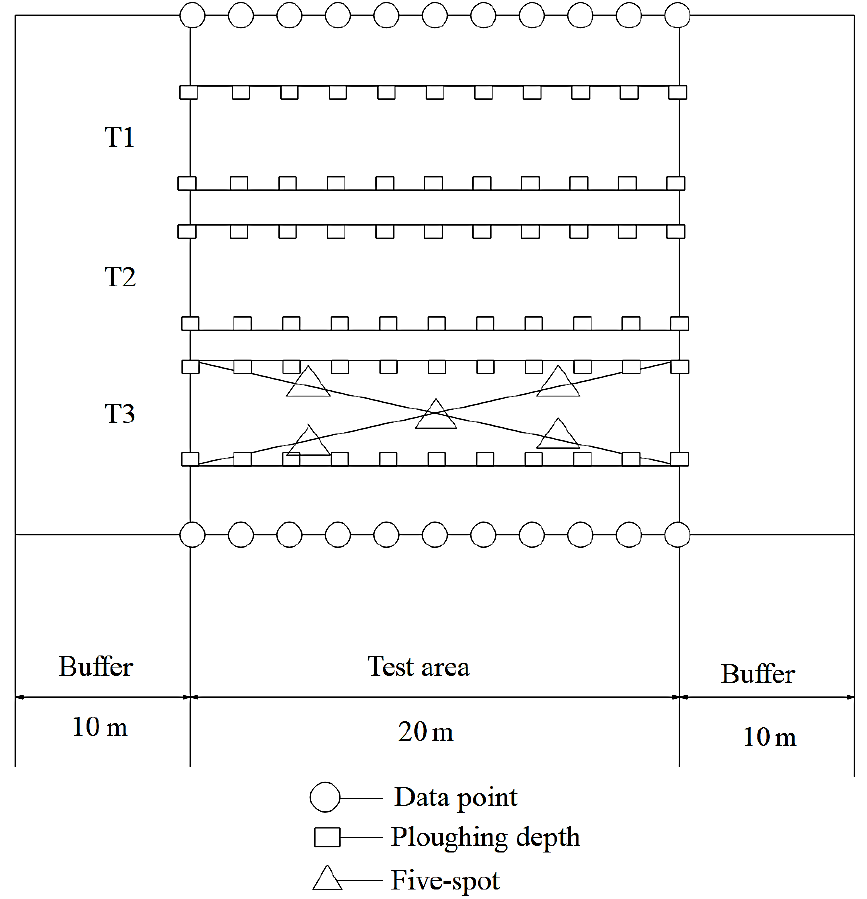
Figure 8. Data acquisition hint.